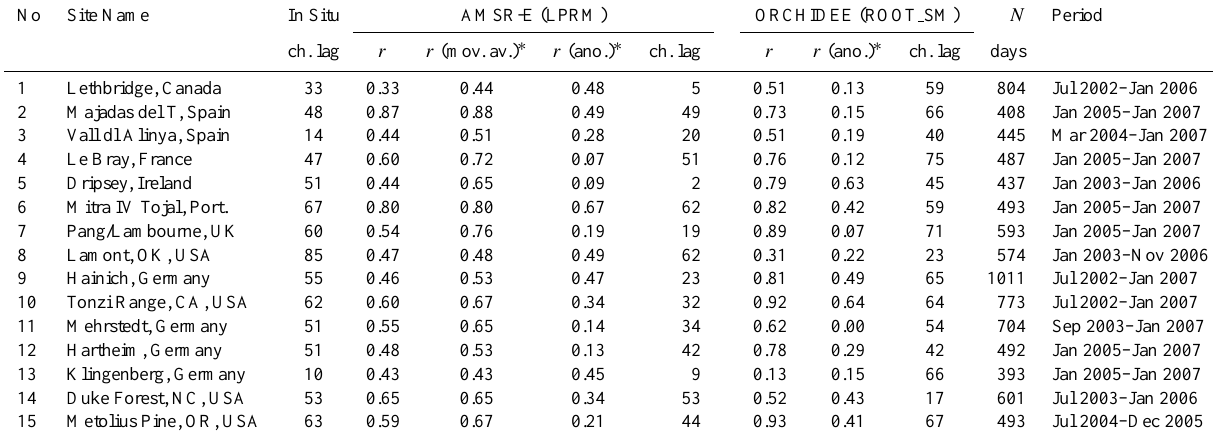
Table 2. Pearson’s correlation coefficient ( r ), and characteristic lag-times (ch. lag) in days of the FLUXNET in situ measurements, AMRS-E (LPRM) and ORCHIDEE (ROOT SM).